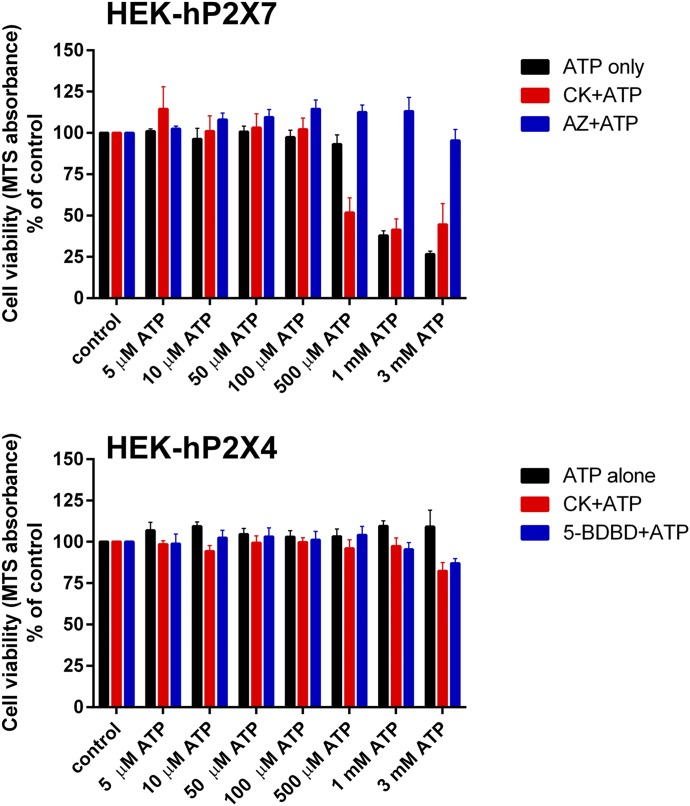
Ginsenoside CK does not enhance cell death in HEK-hP2X4 cells. HEK-293 cells stably expressing hP2X4 or hP2X7 (50,000 cells/well) were plated into 96-well plates for 24 hours prior to stimulation with ATP. Cells were pretreated with antagonists AZ10606120 (AZ) or 5-BDBD for 10 minutes before ATP was added. Cells were exposed to the indicated concentrations of ATP or ATP + CK (10 μM) for 24 hours, and viability was measured using MTS absorbance. MTS was added for the final 4 hours of incubation, and absorbance read using a Flexstation 3 reader. Data were normalized to cells treated with vehicle control and are expressed as percentage of control. Data are from four independent experiments.